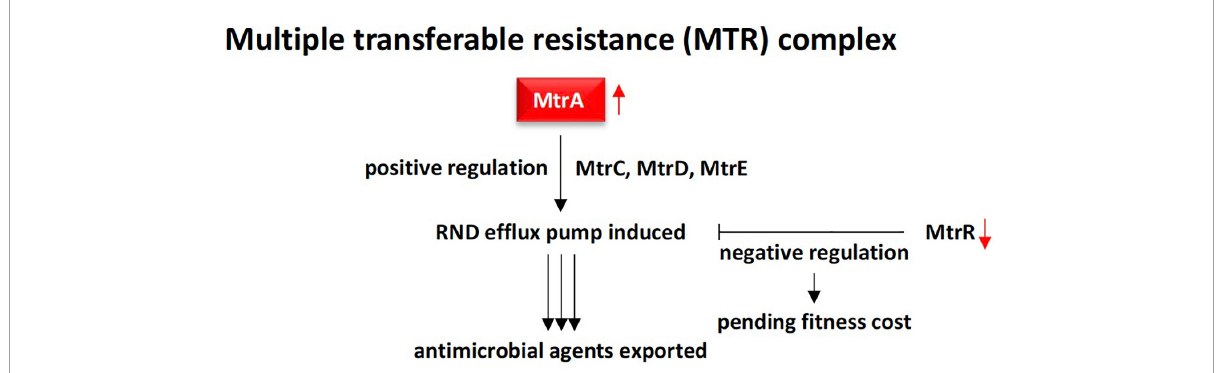
FIGURE7 Demonstration of RND multidrug efflux system contributed by MtrA gonococcal protein (positive regulation) in rhizobiome of M oleifera. This efflux system is effective due to action of the downstream proteins MtrC, MtrD, and MtrE in addition to the absence of the MtrR transcriptional repressor. MtrR contributes to slower growth rate to maintain proper fitness cost.